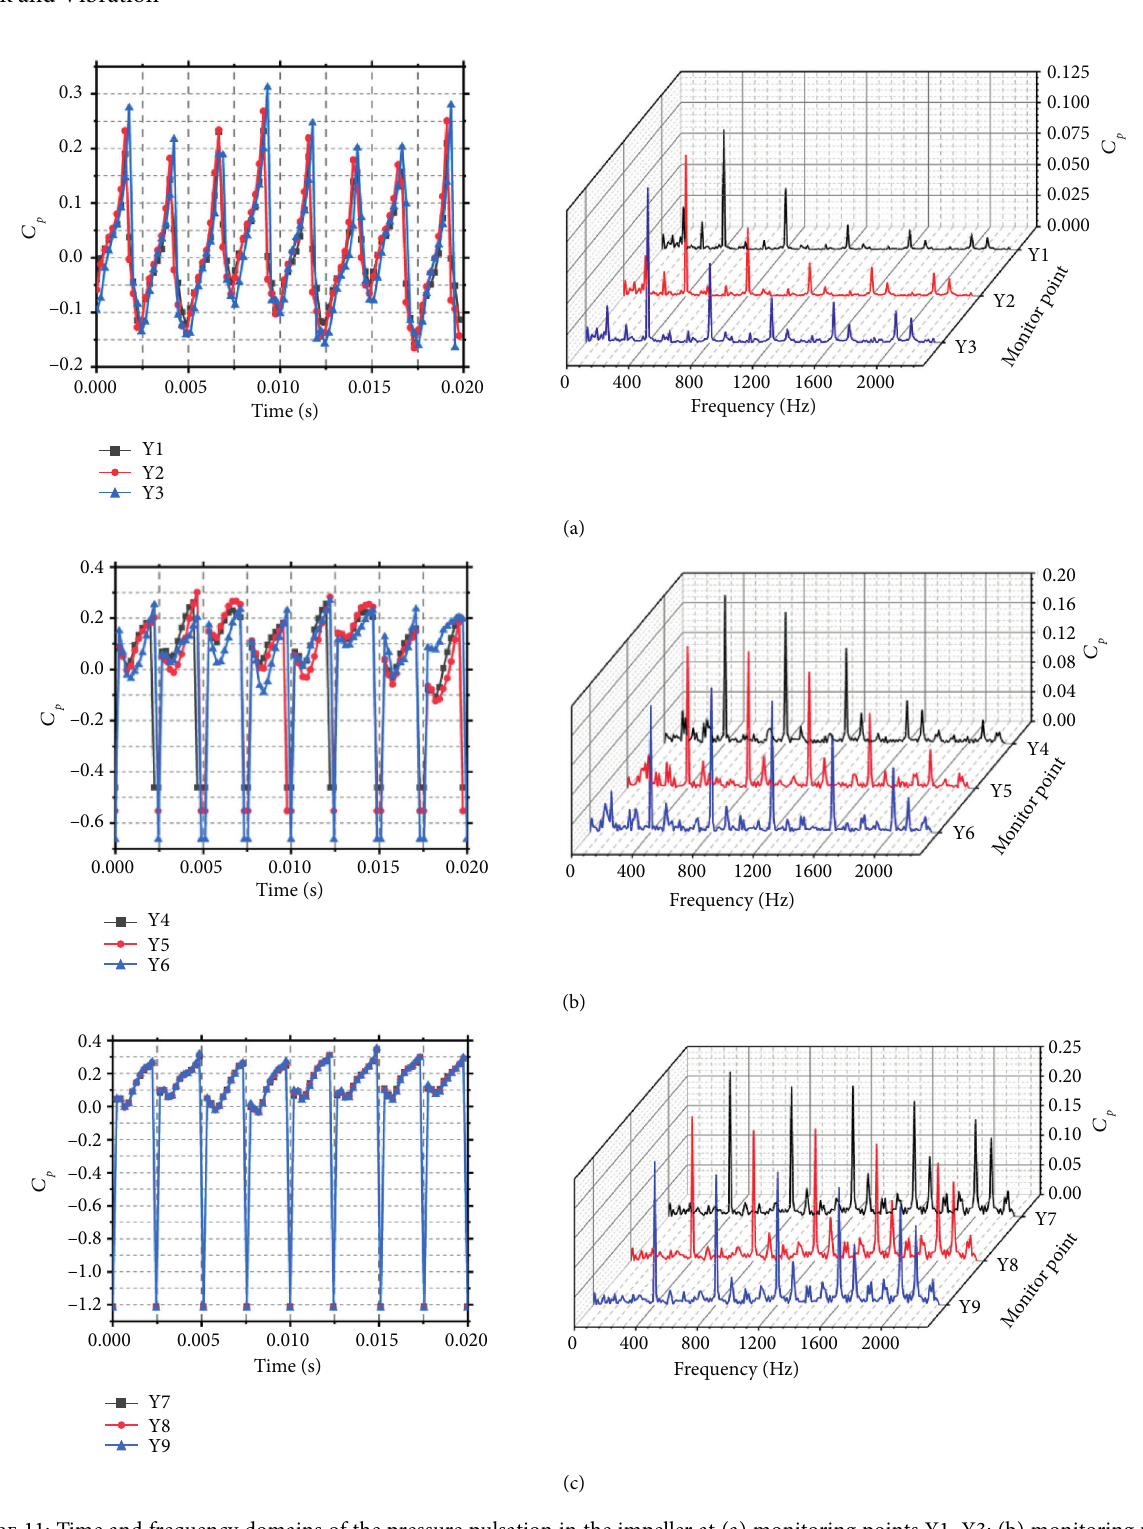
Figure 11: Time and frequency domains of the pressure pulsation in the impeller at (a) monitoring points Y1–Y3; (b) monitoring points Y4–Y6; and (c) monitoring points